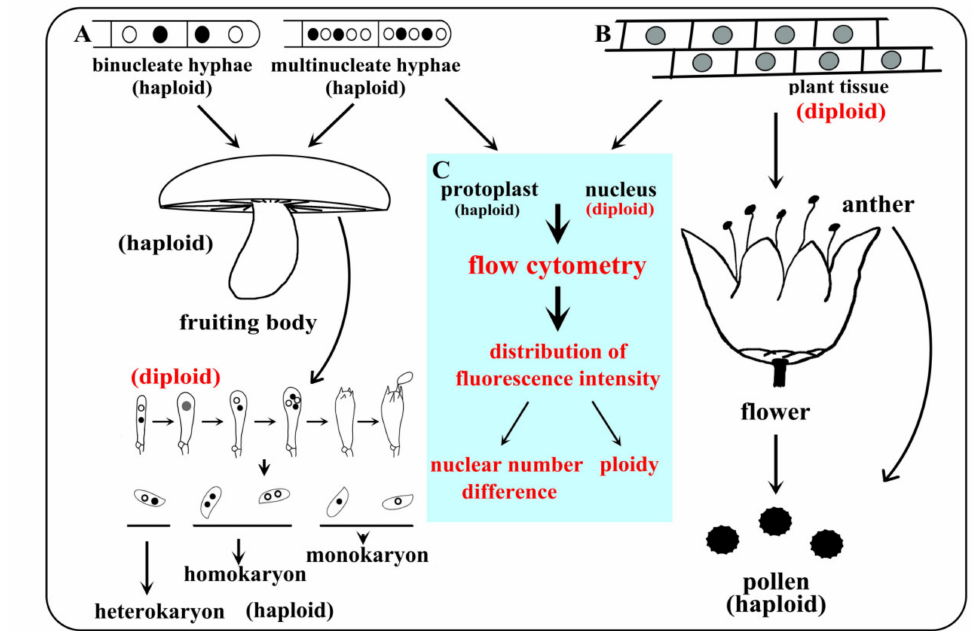
Figure 9. Ploidy change during developmental processes and ploidy analysis routes through flow cytometry in basidiomycetes and plants. ( A ) Ploidy of basidiomycetes at different developmen- tal stages, with the diploid nucleus formed after karyogamy only in basidia; ( B ) Ploidy of plant at different developmental stages, with the haploid nucleus formed after meiosis only in pollen; ( C ) Ploidy analysis for plants and nuclear number analysis for basidiomycetes by flow